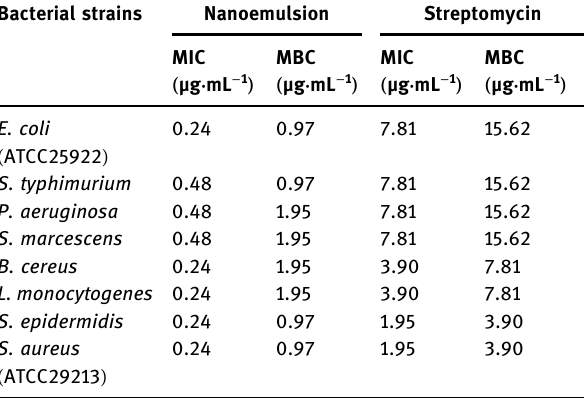
Table 3: MIC and MBC of nanoemulsion against bacterial pathogens Bacterial strains Nanoemulsion